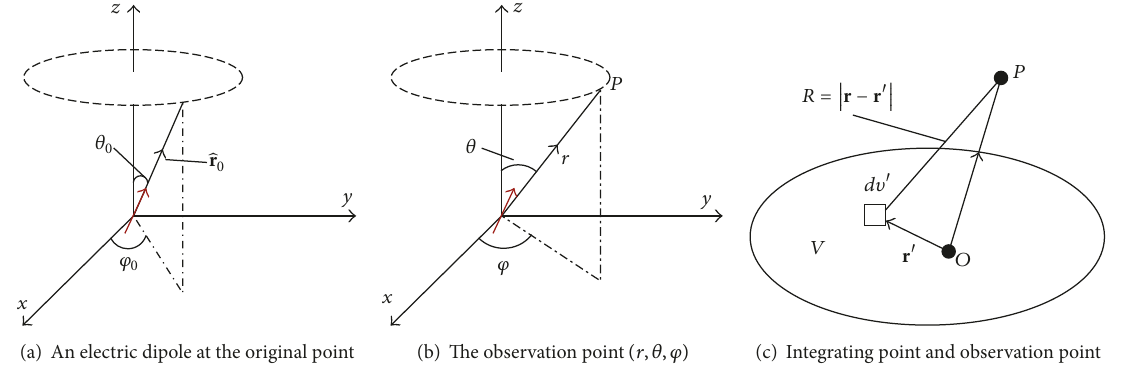
Figure 1: The arbitrarily oriented electric